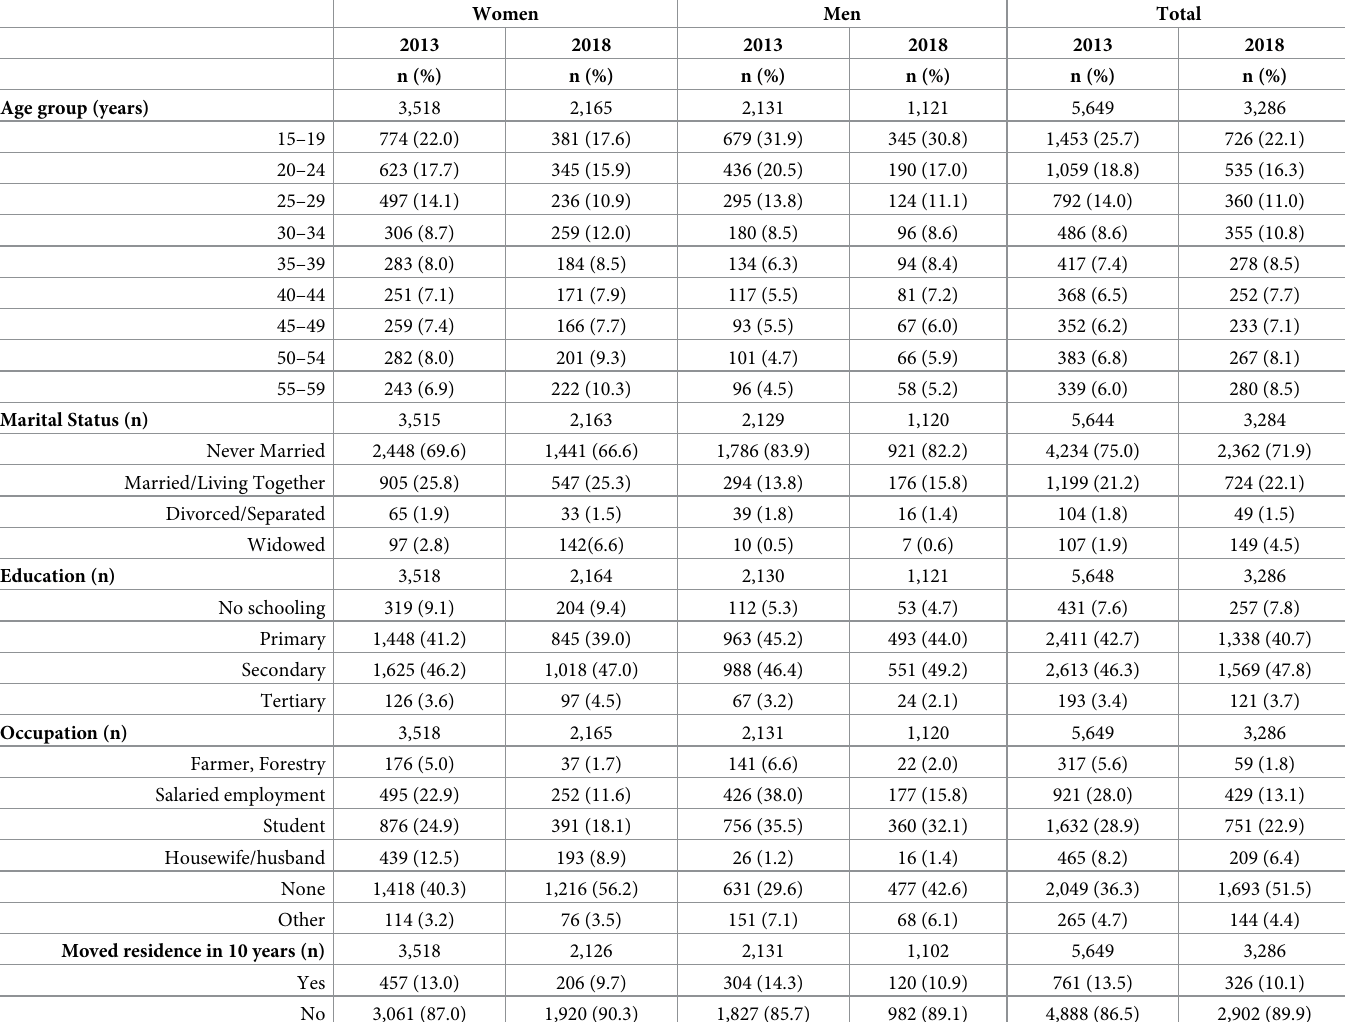
Table 1. Selected sociodemographic characteristics among men and women aged 15–59, 2013 and 2018 surveys.